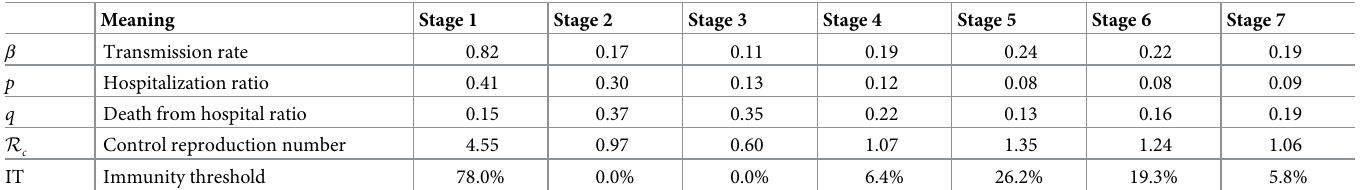
Table 5. Estimation of parameters, control reproduction number, and immunity threshold. The transmission rate β and the control reproduction number R between different stages, indicating that local government policies in New York City and public holidays have a strong impact on the transmission dynamics of the pandemic.